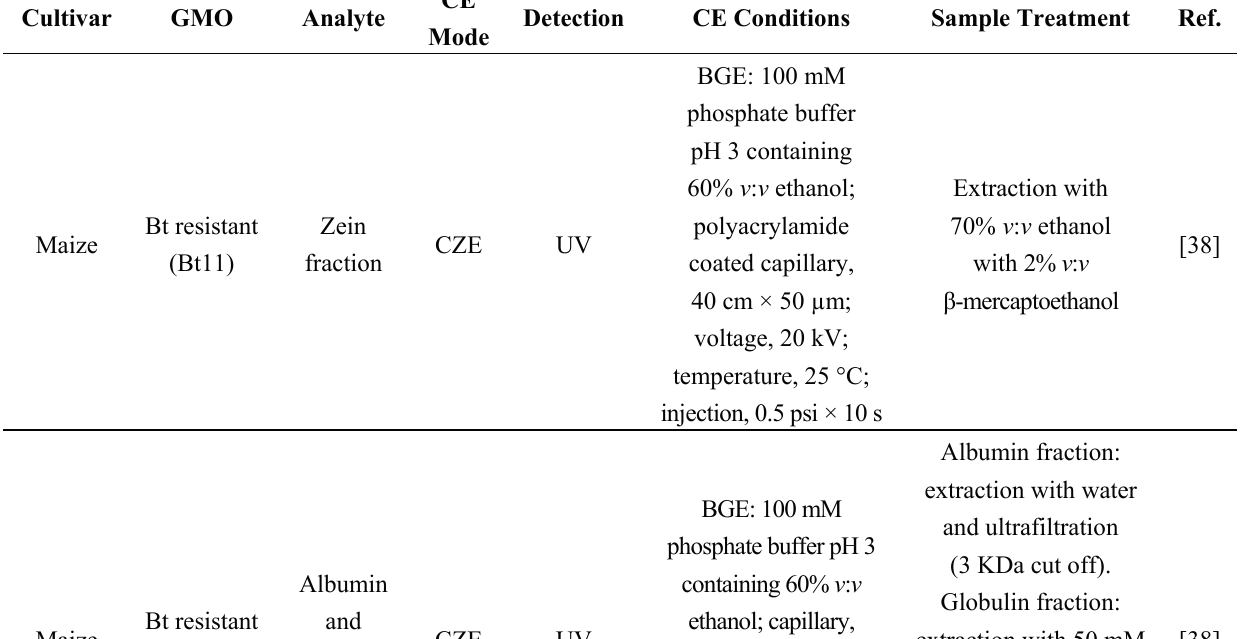
Table 2. Applications of CE in the determination of proteins in transgenic cultivars. CE Cultivar GMO Analyte Detection CE Conditions Sample Treatment Mode